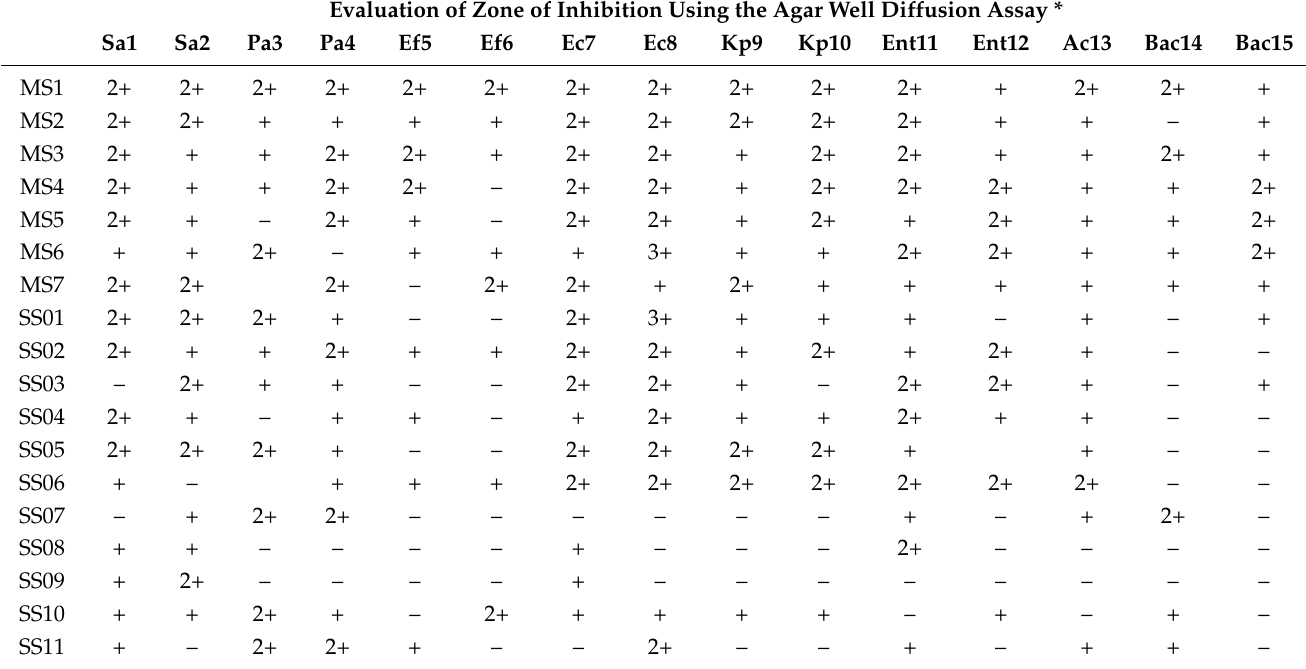
* Cell-free supernatant after filtration; more than 20 mm was considered strong inhibition (3+), between 11 and 20 mm was considered intermediate inhibition (2+), and less than 10 mm was considered low inhibition (+). The diameter of the colony is included. If no zone of inhibition was detected the result was reported as <6 mm (–). As obvious from Table 10, the cell-free supernatants of all multiple-strain probiotics except MS7 exhibited an intermediate average inhibition (zone of inhibition was between 10 and 20 mm). All cell-free supernatants of single-strain probiotics and MS7 exhibited only a low inhibition (the zone of inhibition was less than 10 mm). Only two probiotics (MS6 and SS01) exhibited high inhibition of cell-free supernatant, both for the same clinical strain of Escherichia coli . No pathogen stood out in its resistance against the cell-free supernatants. All results show a lower inhibition ability of the cell-free supernatant compared to probiotics. As obvious from Table 11 (Supplementary Table S4) the neutralized cell-free super- natants of all probiotic strains exhibited only low average inhibition for all investigated clinical pathogens from wounds. Only one neutralized cell-free supernatant of Limosilacto- bacillus reuteri DSM 17938 exhibited a strong inhibition against one clinical strain from the Bacteroides genus. No pathogen stood out in its resistance against the neutralized cell-free supernatants. All results show a lower ability of the neutralized cell-free supernatant compared to cell-free